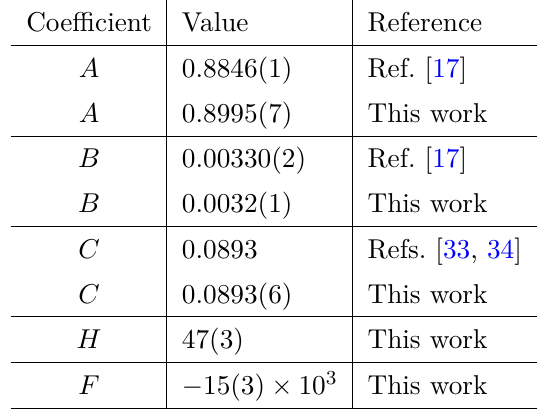
Table 2. Comparison of the values of the fit parameters appearing in eqs. (3.7) and (3.8). We will also use eq. (3.8) to fit our b T ref. [17] reports A = 0 . 8846(1) and B = 0 . 00330(2) from a fit to their critical